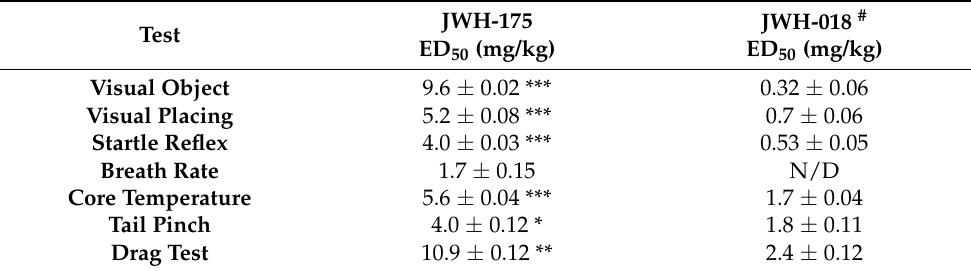
Table 2. ED50 values of JWH-175 in comparison to JWH-018. Data represent ED50 + SEM. ED50 has been calculated by non-linear regression curve fitting of the dose–response curves determined using Prism 8.0 software (GraphPad Prism, San Diego, CA, USA). Curves have been compared, when possible, by performing F test (curve comparison). * p < 0.05, ** p < 0.01, *** p < 0.001 versus JWH-018. # JWH-018 data were elaborated from